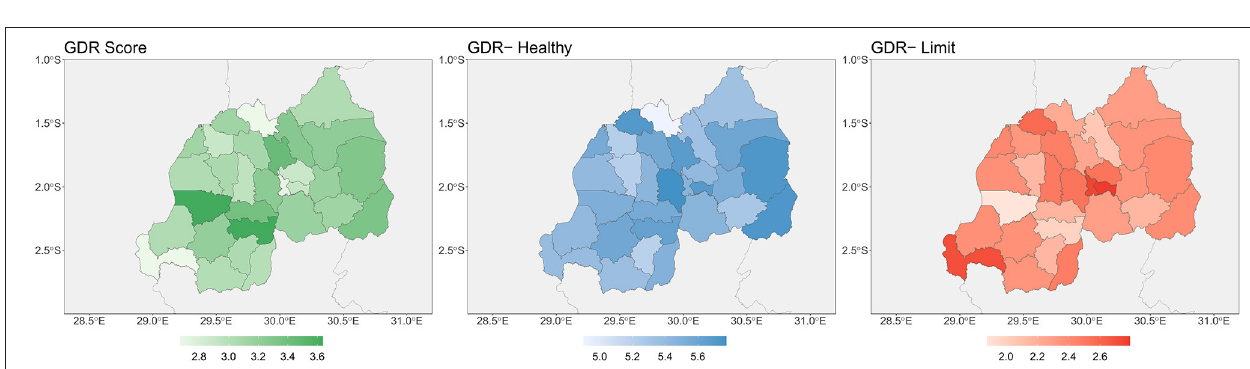
FIGURE 6 | Geographic distribution of the diet quality